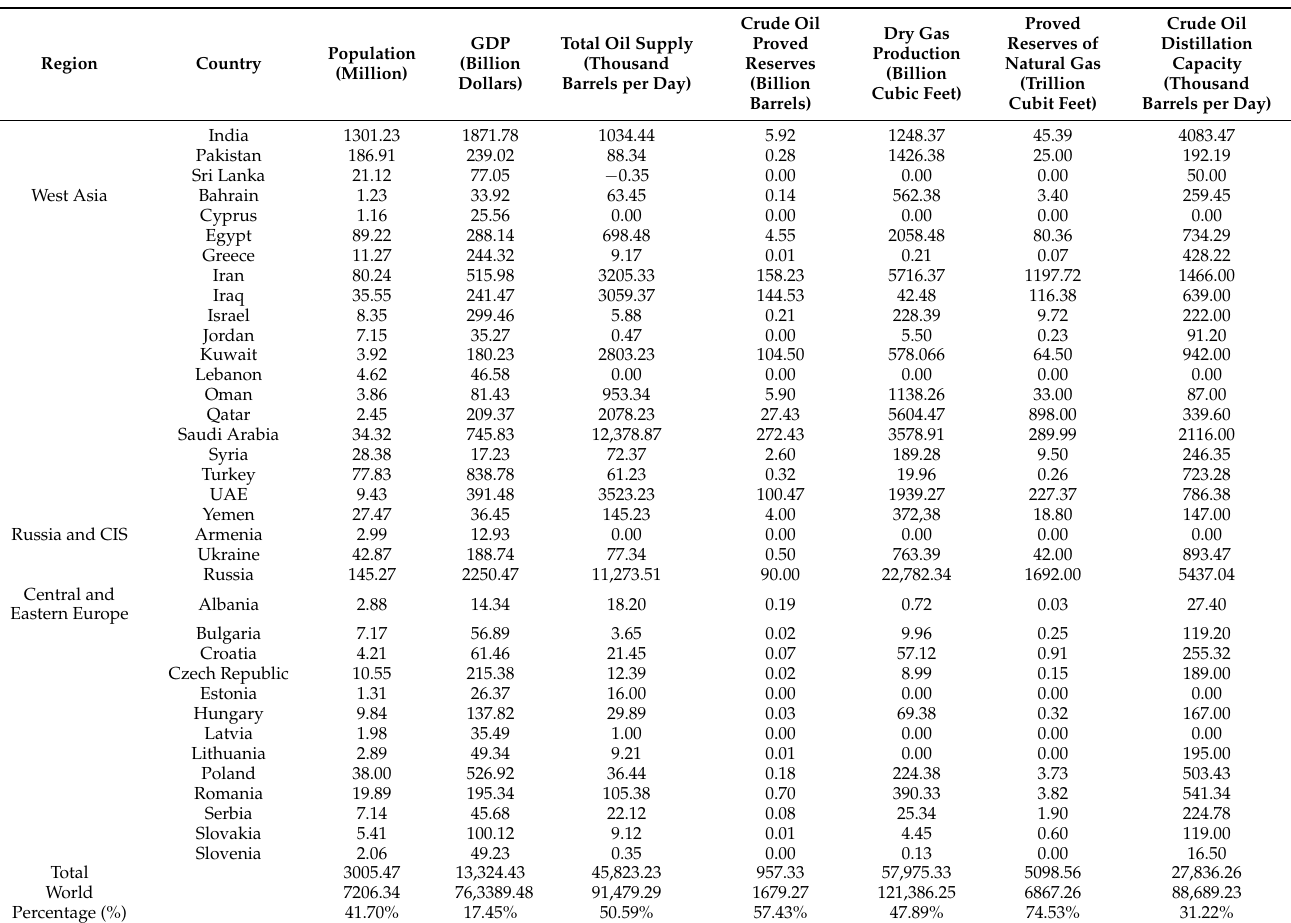
Table A4. Main statistics of 50 Nations alongside the China’s “Belt & Road Initiative in 2016”.